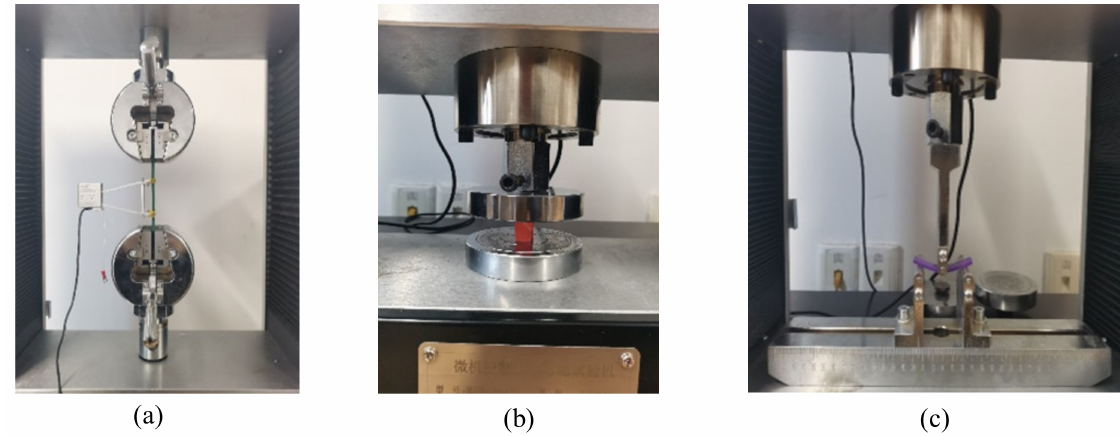
Figure 4. Experimental tests for specimens: ( a ) tensile, ( b ) compressive and ( c ) flexural.